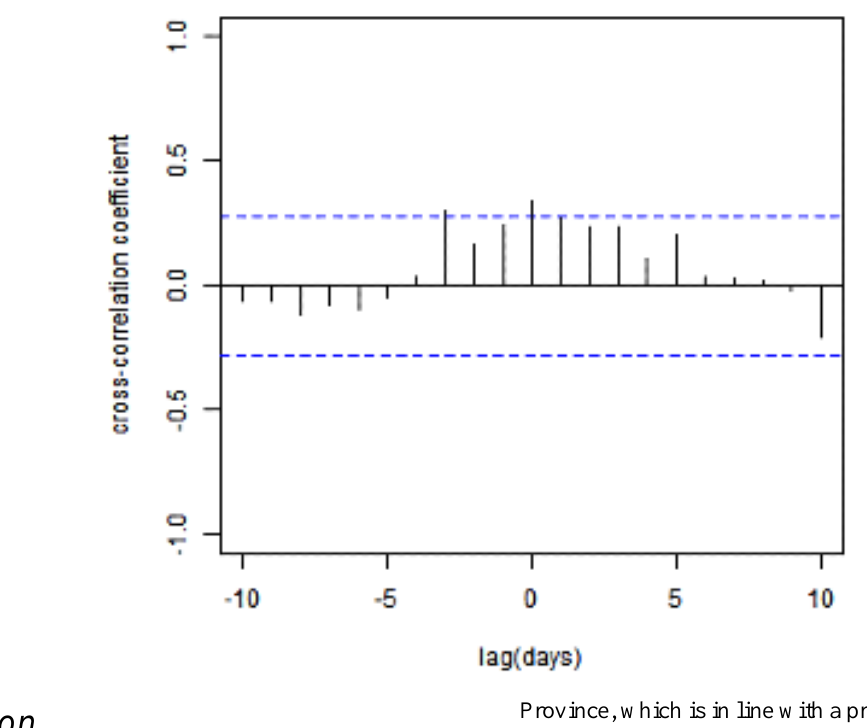
Figure 5. Cross-correlation between fear and fearful rumors. Blue dashed lines denote the 95% confidence intervals of the uncorrelated time